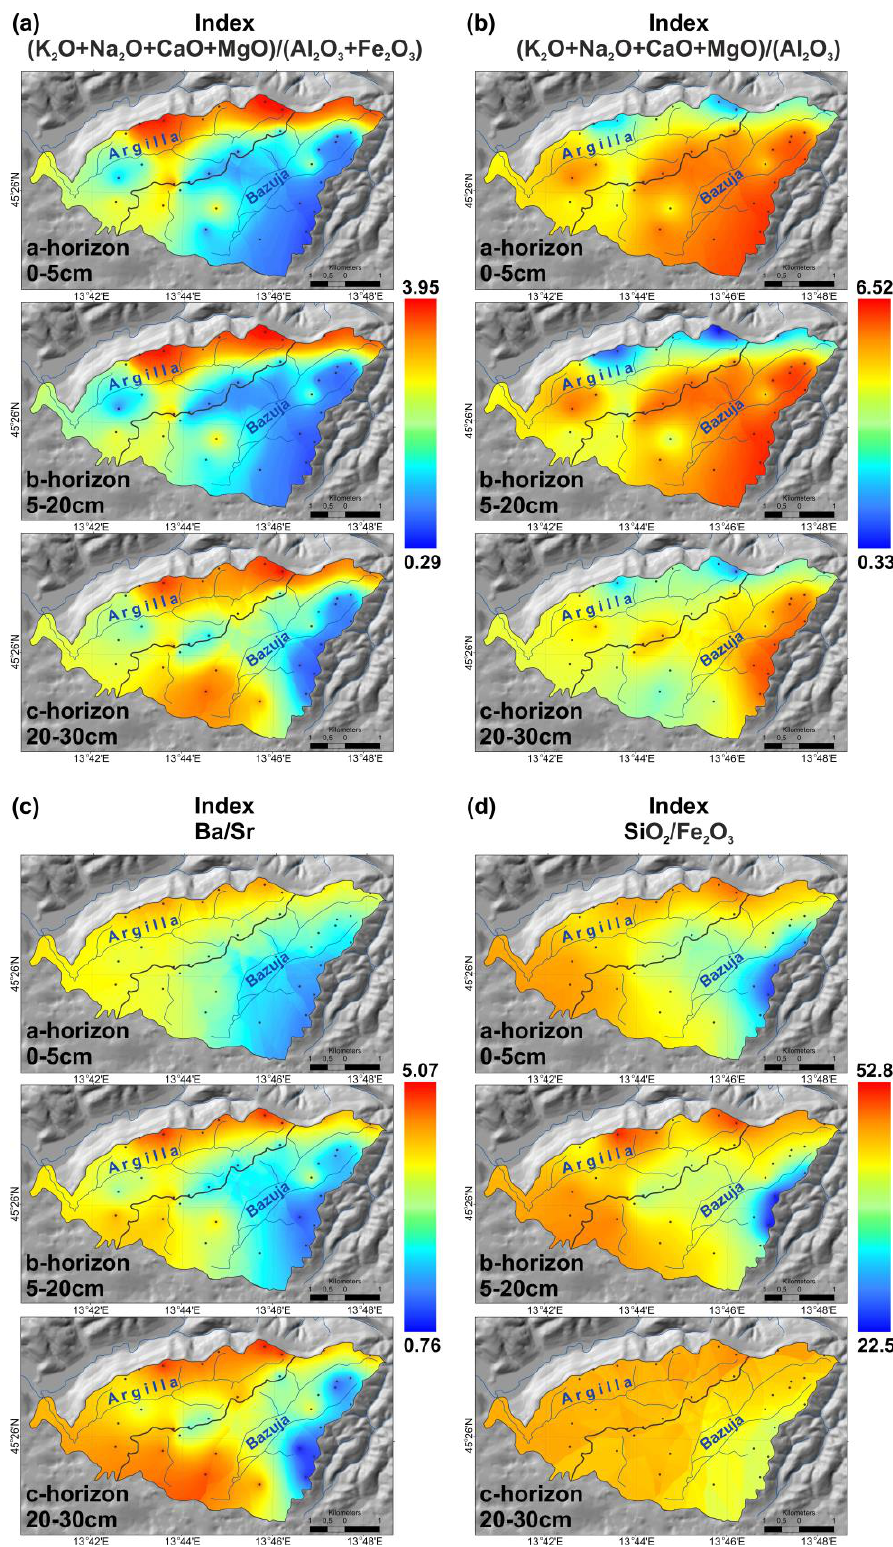
Figure 2. Distribution of weathering indices ( a ) (K 2 O + Na 2 O + CaO + MgO)/(Al 2 O 3 + Fe 2 O 3 ); ( b ) (K 2 O + Na 2 O + CaO + MgO)/Al 2 O 3 ; ( c ) Ba/Sr; ( d ) SiO 2 /Fe 2 O 3 in different soil horizons in the rivers’ Argilla and Bazuja’s catchments.